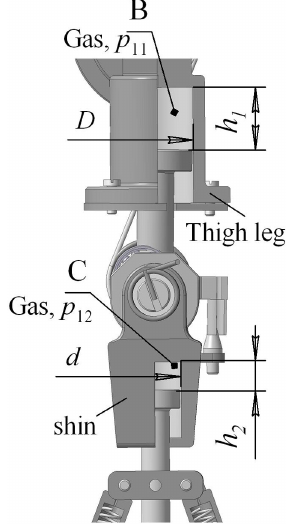
Figure 5. Parameters of the gas chambers of the thigh and lower leg of the robot's